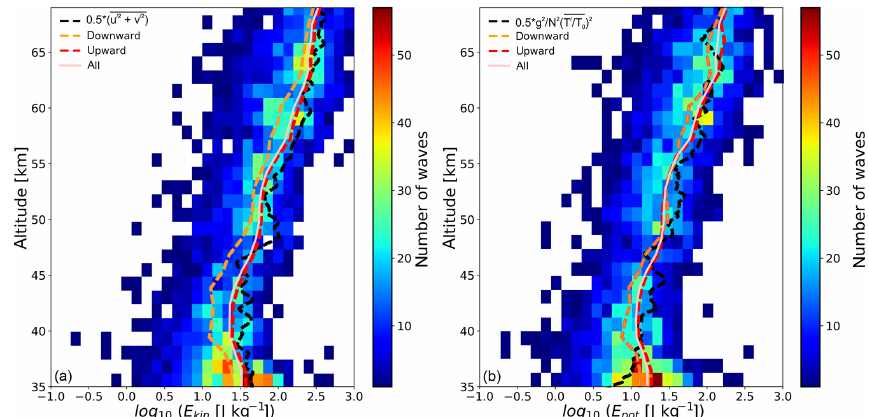
Figure 14. Kinetic (a) and potential (b) energy of waves. Colored boxes show 2-D histograms (number of waves per 1.5km altitude and 0.15 log(energy) bin). Lines show mean values of whole distribution (pink) and upward- or downward-propagating waves (red and orange dashed), and black dashed lines are energy estimated from the variance in the temperature (a) and wind (b) fluctuations throughout the measurement.